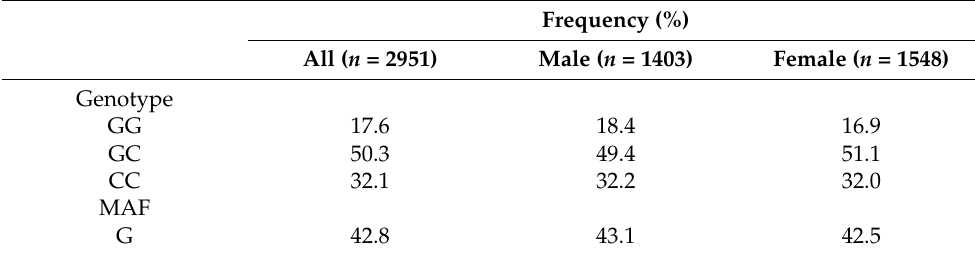
Table 2. Genotypes of the MTNR1B rs10830963 in the study participants.